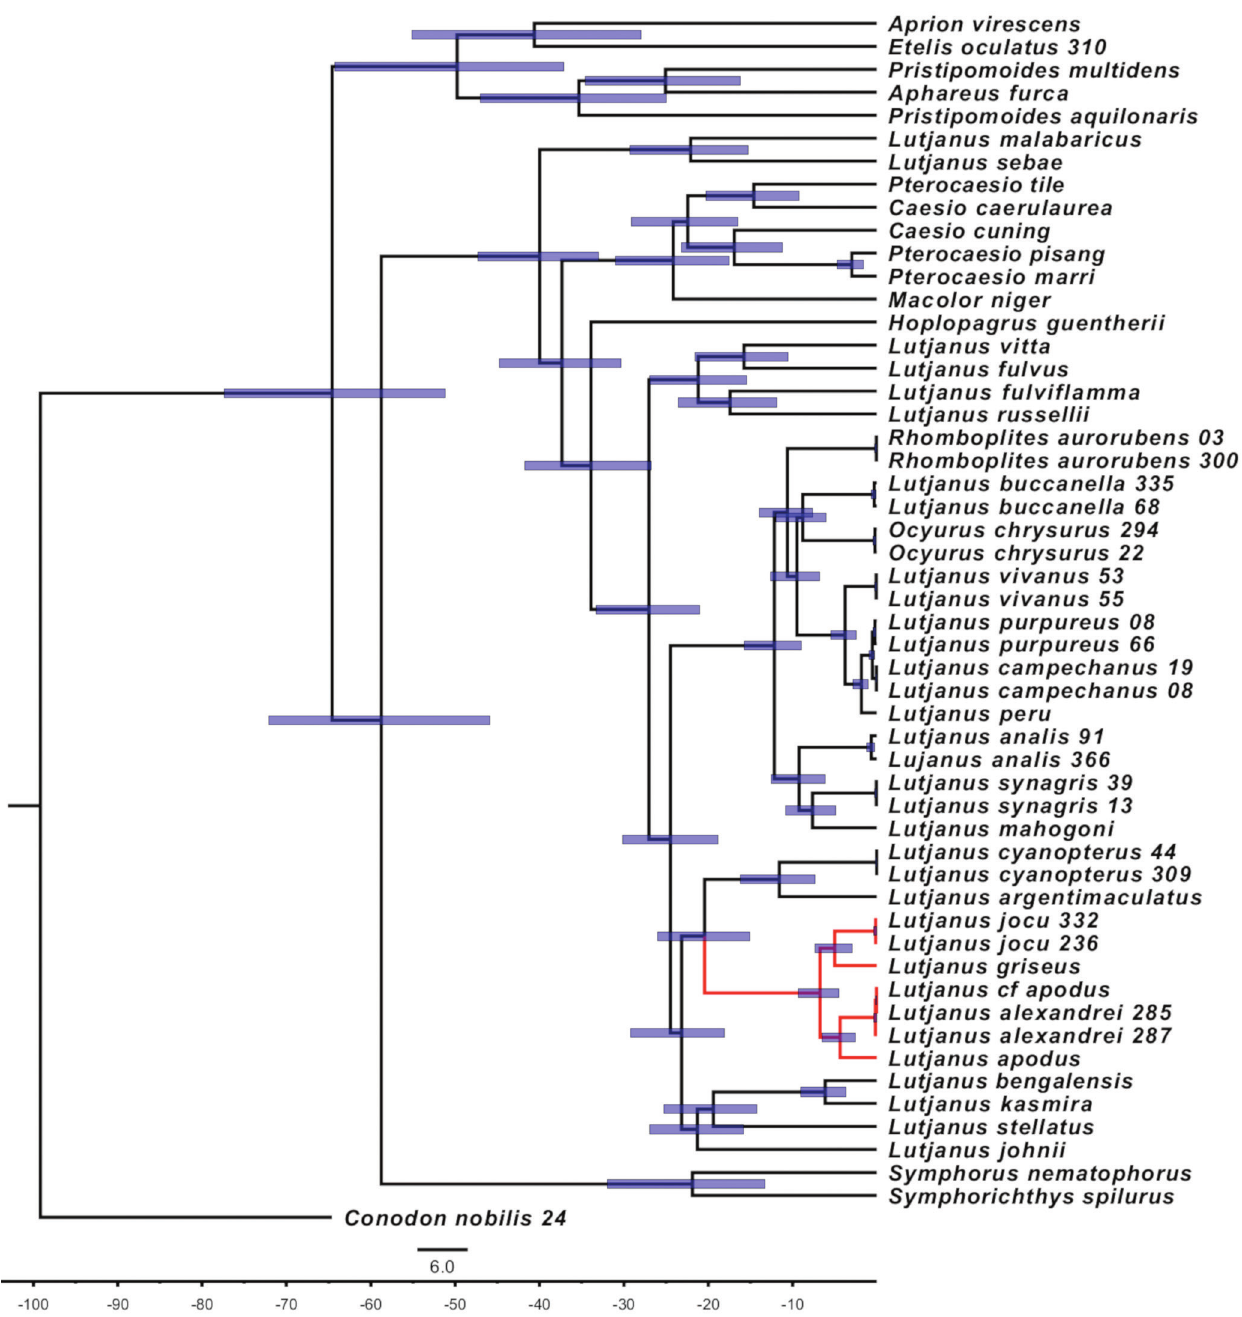
Fig. 2. Bayesian inference based on the 3.0 kb dataset of mtDNA (16S, COI, and cyt b) and nuclear (RAG-1) sequences in 40 Lutjanidae species. The dating was based on the estimated minimum age for the oldest fossil reported to the family. The branch mainly discussed in the text is highlighted, revealing the origin of Lutjanus alexandrei between 2.5 – 6.5